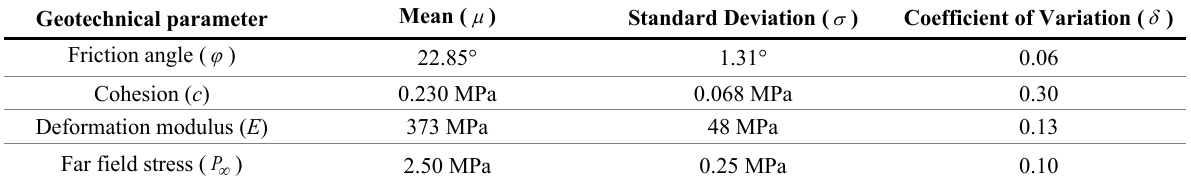
Table 1. Geotechnical statistical parameters for tunnel A [6].